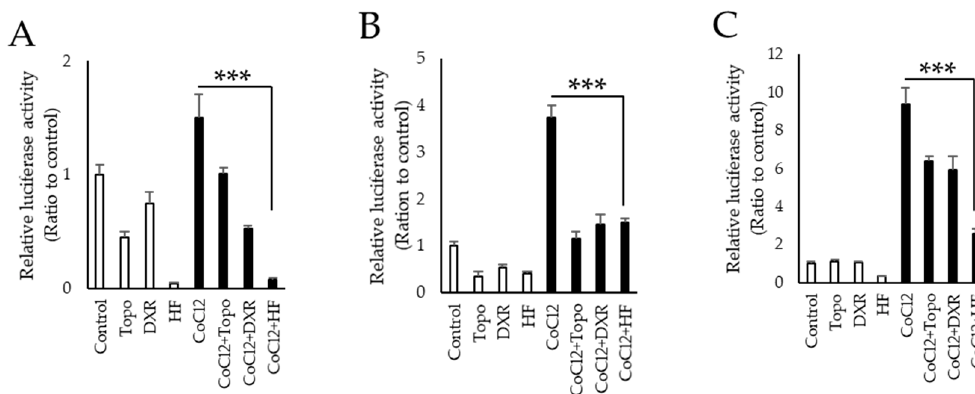
Figure 1. Hypoxia-inducible factor (HIF) inhibitory effects of halofuginone in vitro. HIF-reporter luciferase assay was performed in NIH/3T3 ( A ), 661W ( B ), and ARPE19 ( C ) cell lines ( n = 3). Topotecan, doxorubicin, and halofuginone (100 μ M) were administrated in normal or CoCl 2 -induced cultured condition. Note that halofuginone inhibited CoCl 2 -induced HIF activities stronger than two known HIF inhibitors. Error bars indicate the standard deviation. HF; halofuginone, Topo; topotecan, DXR; doxorubicin, CoCl 2 ; cobalt chloride. *** p < 0.001, Student’s t -test.